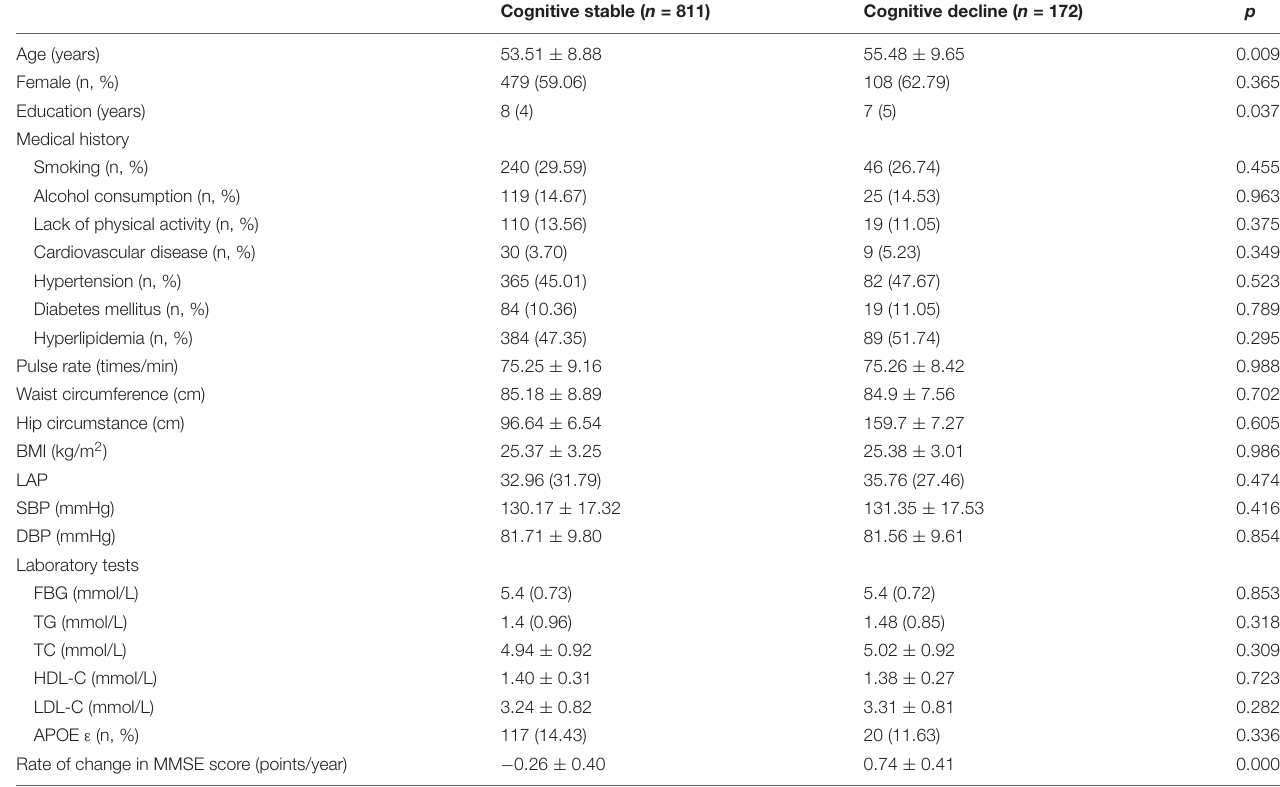
Cognitive stable ( n =